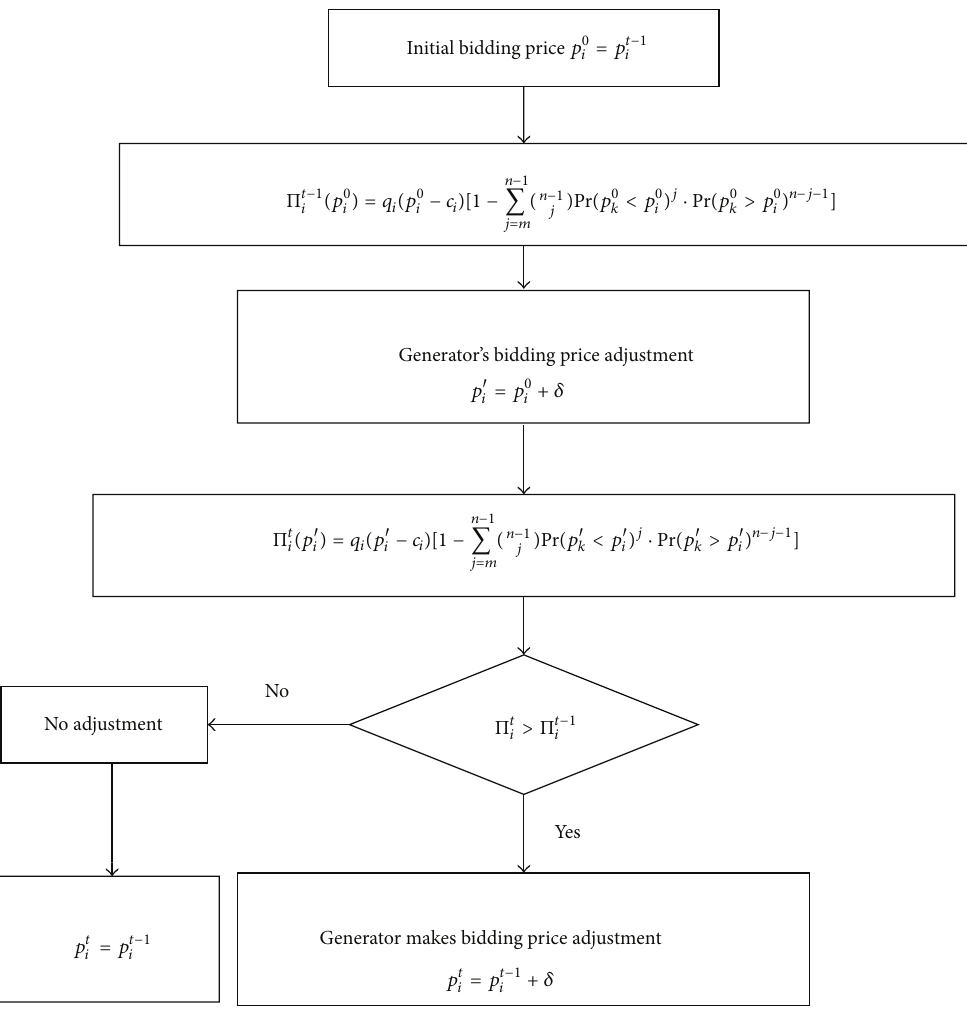
Figure 1: The best-response dynamic process of producer’s bidding